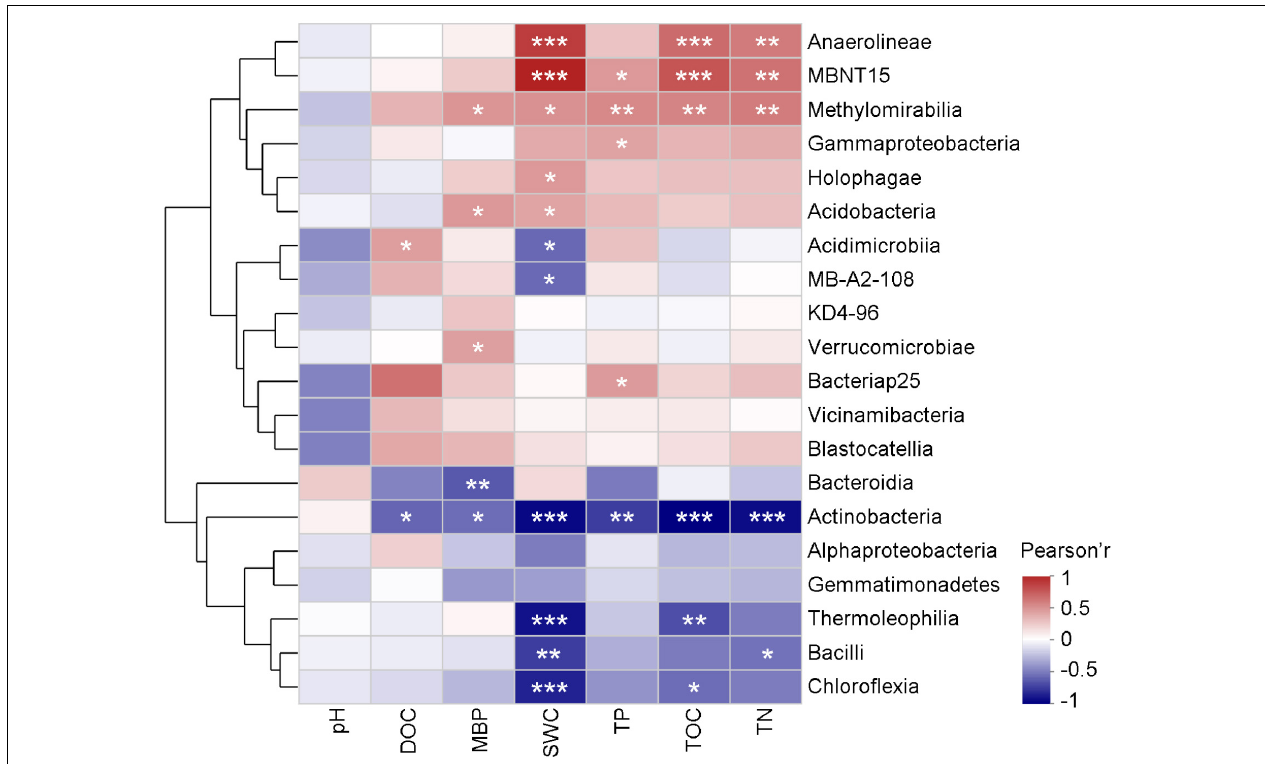
FIGURE 4 | Heatmap showing the correlation between soil properties and the main microbial classes. *, **, and *** indicate significant correlations at P < 0.05, 0.01, and 0.001, respectively. DOC, dissolved organic carbon; MBP, microbial biomass phosphorus; SWC, soil water content; TP, total phosphorus; TOC, total organic carbon; TN, total